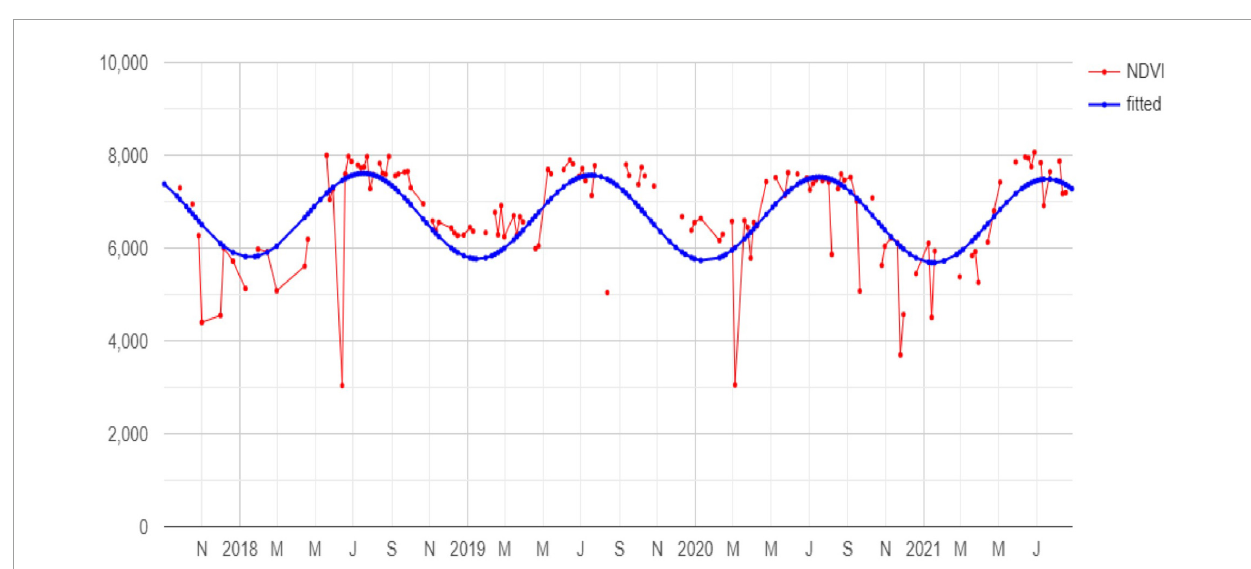
FIGURE2 Example of NDVI pixel time series (red) and the corresponding fitted harmonic function (blue).